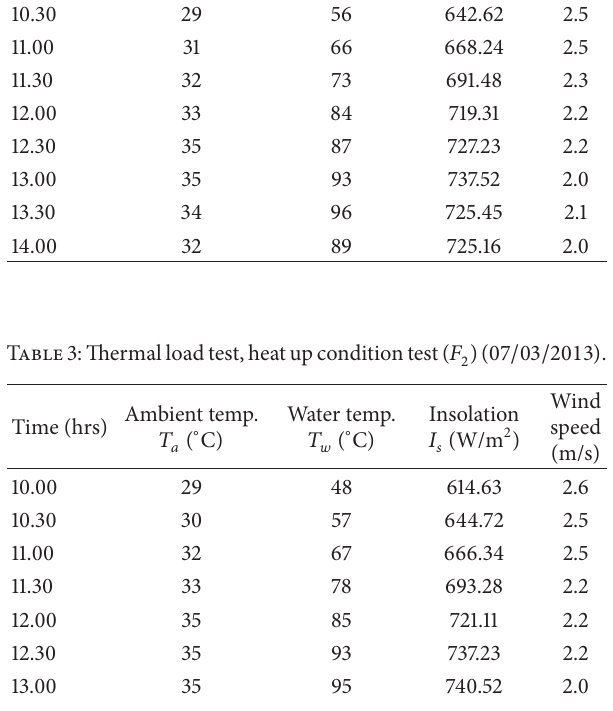
Table 2: Thermal load test, heat up condition test (𝐹 2 ) (06/ 03/2013) . Ambient temp. Time (hrs) ∘ C) 𝑇 𝑎 (